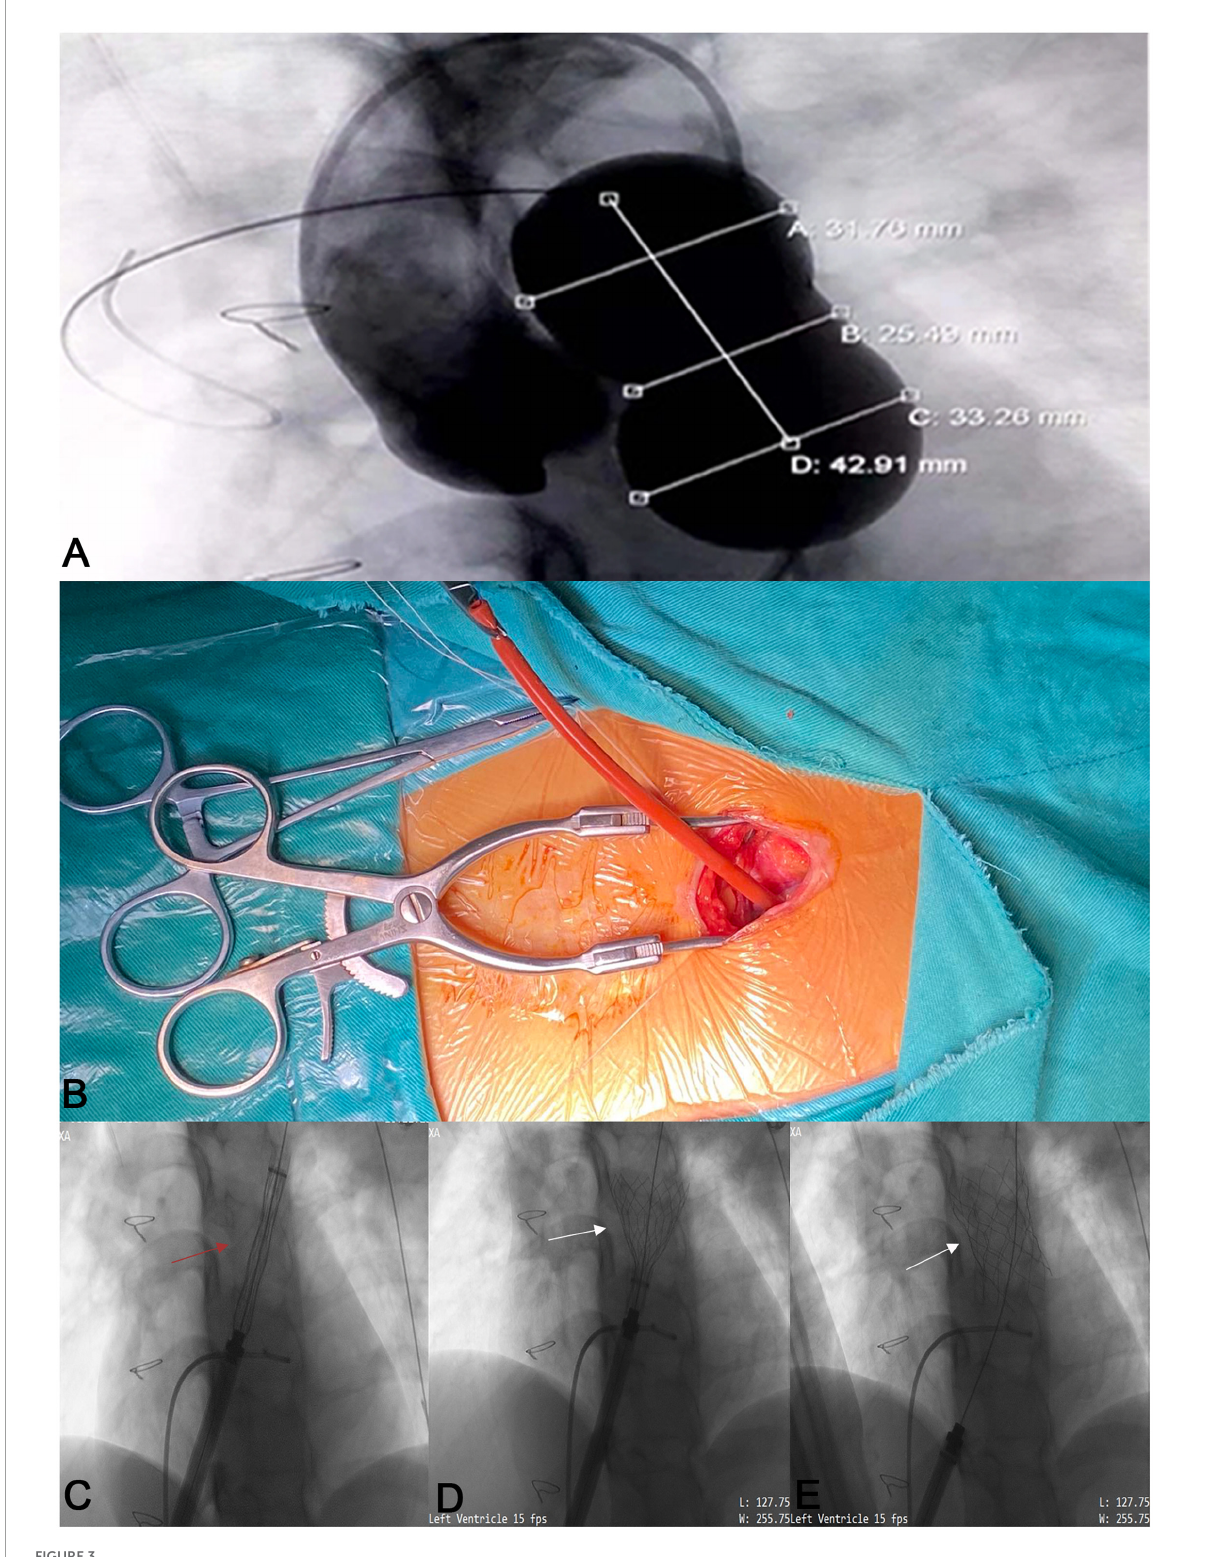
FIGURE3 The process of the novel Salus-Valve via subxiphoid approach. Intraoperative pulmonary angiography and compliant balloon measurement (A) . A 3 cm subxiphoid incision (B) . The assembled delivery system (red arrow) was conveyed to the preplanned location (C) and release the Salus valve (white arrows) (D,E)